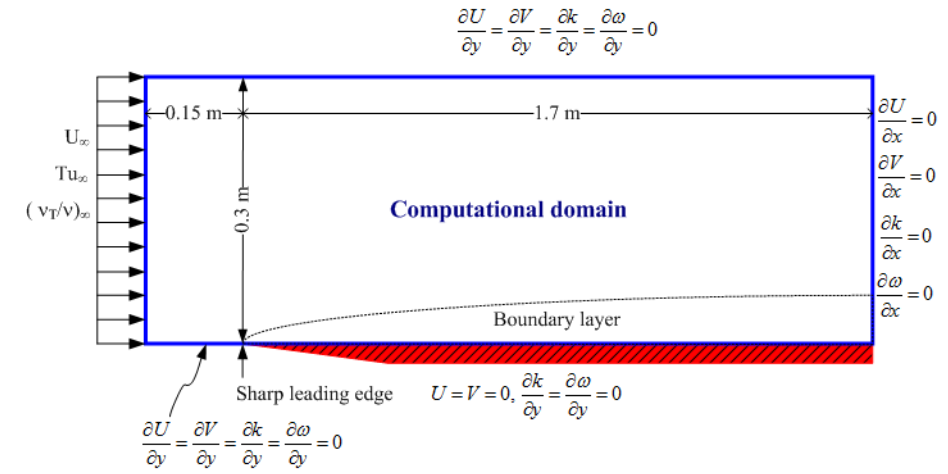
Figure 1. Computational domain and boundary conditions of T3A.